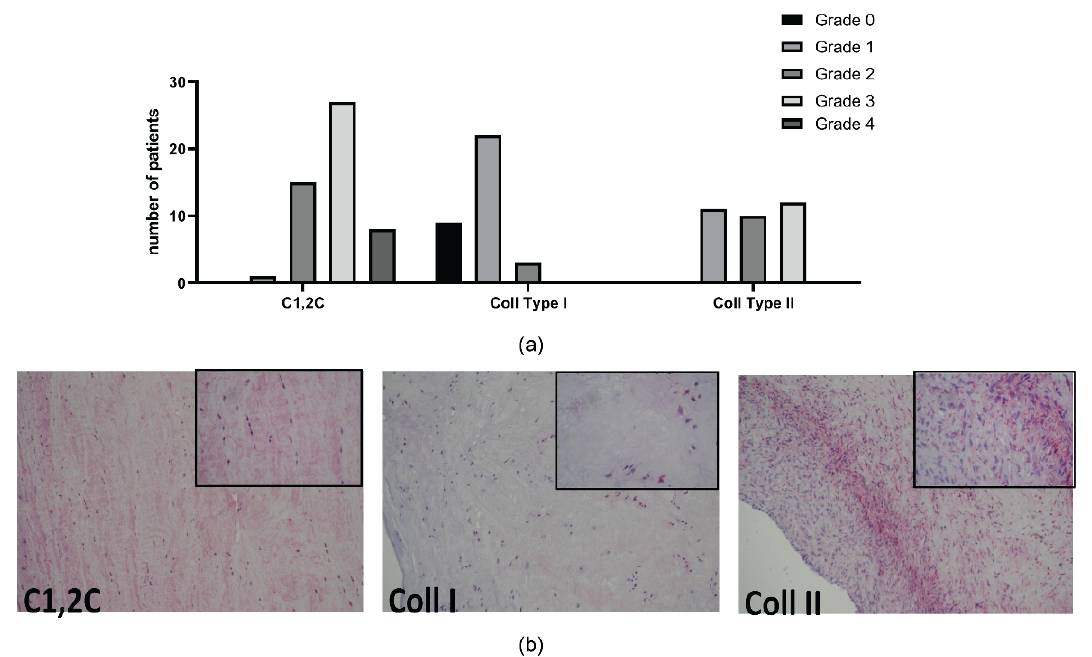
Figure 4. Immunohistochemistry of collagens in meniscal samples. ( a ) number of patients with different expressions of C1,2C, Coll Type I and II; ( b ) one representative patient for each marker (grade 3, 2, 3, respectively) (magnification 10 × , inset 40 × , respectively).